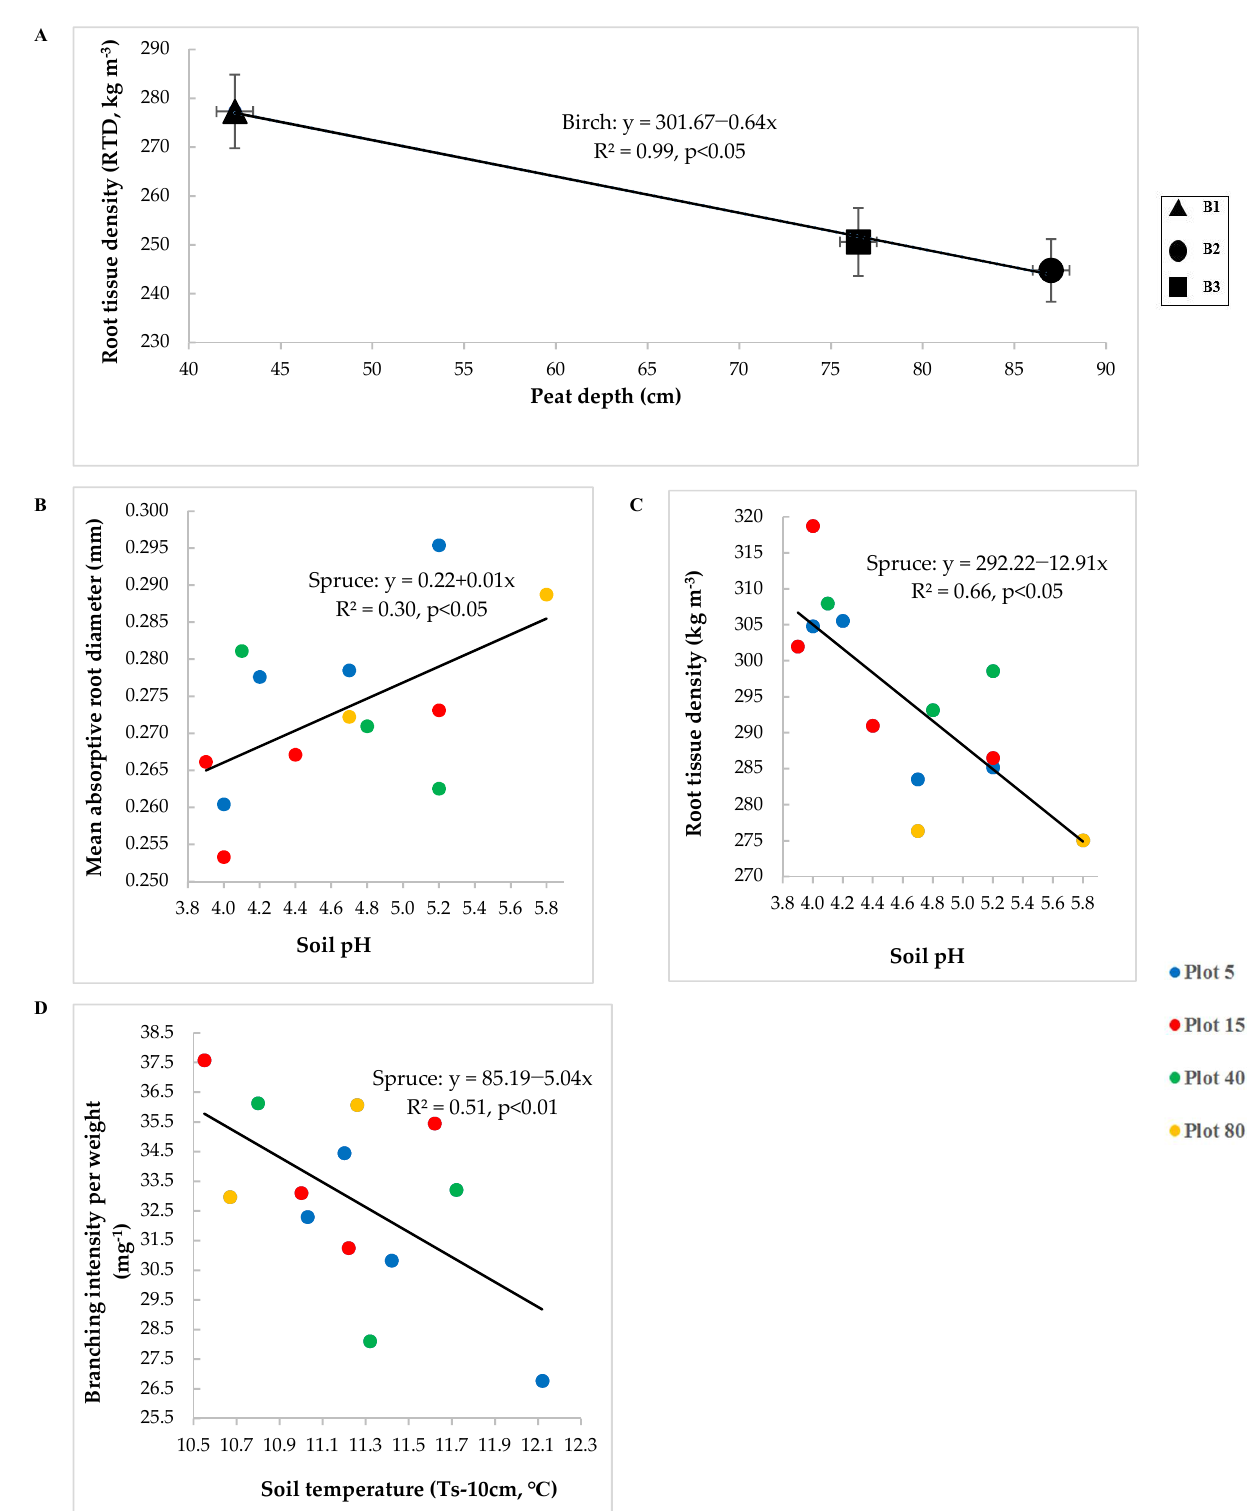
Figure 2. Relationships between absorptive root morphological traits of studied stands in birch ( A ) and all sampling plots (5, 15, 40, and 80) in spruce with the soil characteristics ( B – D ). The soil temperature was measured from a depth of 10 cm. Based on RDA forward selection analysis, a total of 65.4% of the variation in absorptive root morphological traits was explained by tree species, B1 and S2 stands, sampling plots